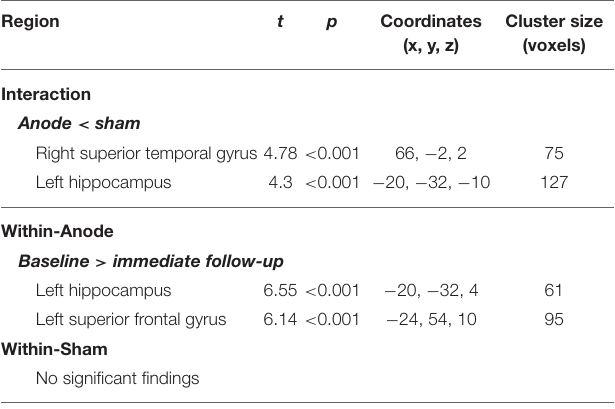
Frontiers in Neurology |